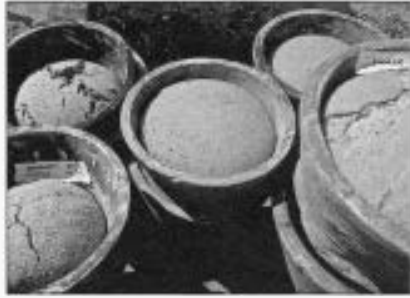
Figure 7 Experimentally baked bread (using various mixtures of emmer wheat and barley) in locally made reconstruc­ tions of the type of mould used at ancient